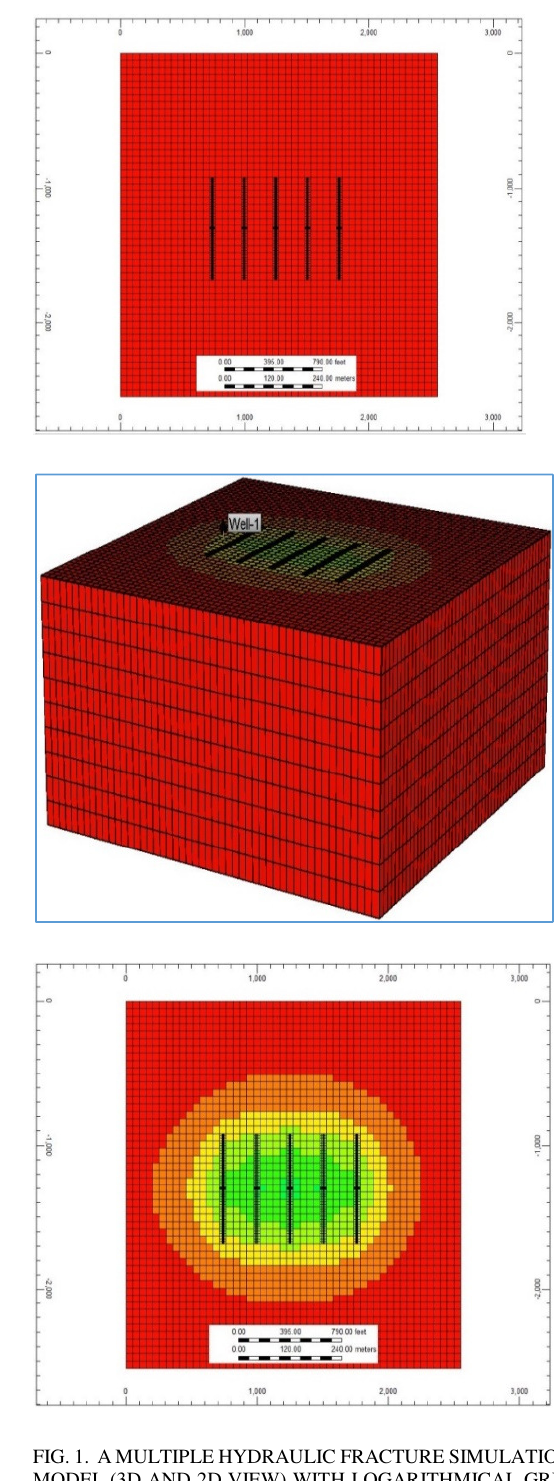
FIG. 1. A MULTIPLE HYDRAULIC FRACTURE SIMULATION MODEL (3D AND 2D VIEW) WITH LOGARITHMICAL GRID REFINEMENTS DEVELOPED USING GEM CMG SOFTWARE. IN ILLUSTRATION, THE UPWARD SHOWS THE MODEL AT INITIAL CONDITIONS AND DOWN IS PRODUCTION